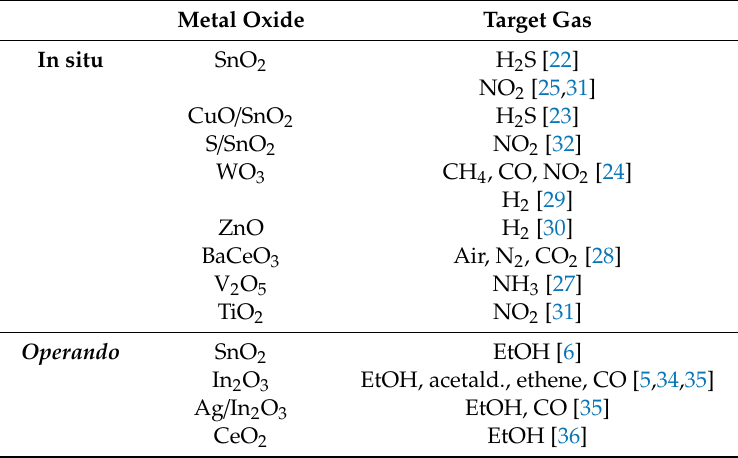
Table 1. Overview of in situ and operando Raman studies on metal-oxide gas